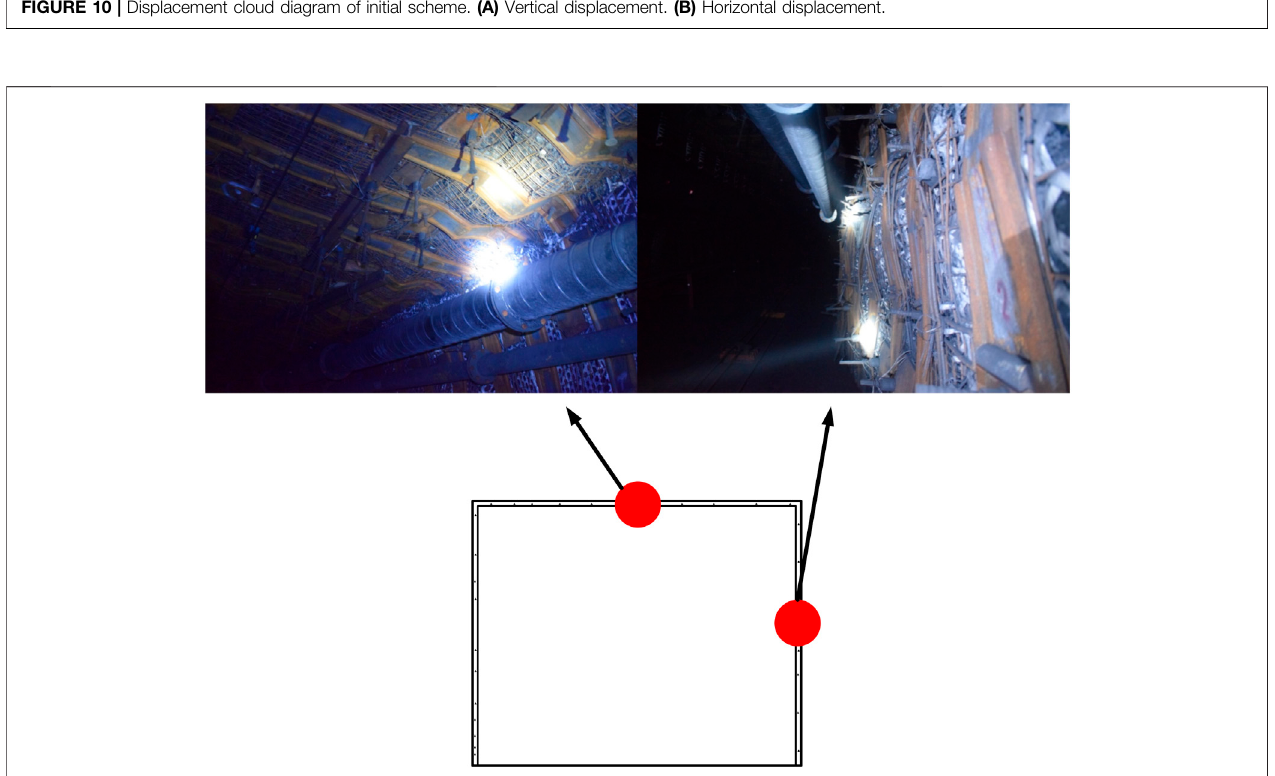
FIGURE 11 | Supporting effect of improve